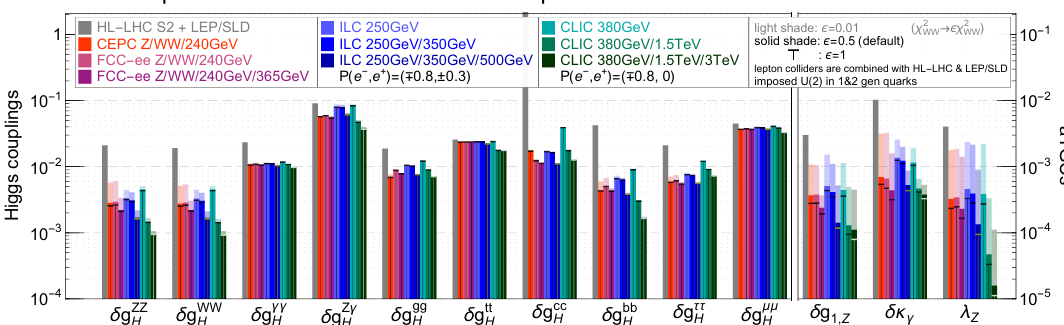
Figure 6 . Impact of diboson measurement precision on Higgs and triple-gauge couplings. Our default assumption, adopted in (cid:12)gure 2, is also shown here as dark-shaded bars. It corresponds to an overall e(cid:14)ciency (cid:15) of 50% (see subsection 2.3). The results obtained with an ideal 100% and a lower 1% e(cid:14)ciency are shown as vertical lines and light shaded bars respectively. The run scenarios of the future lepton colliders are summarized in table